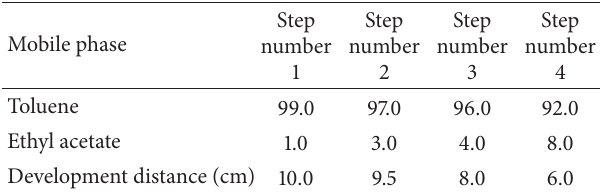
Development distance (cm) 10.0